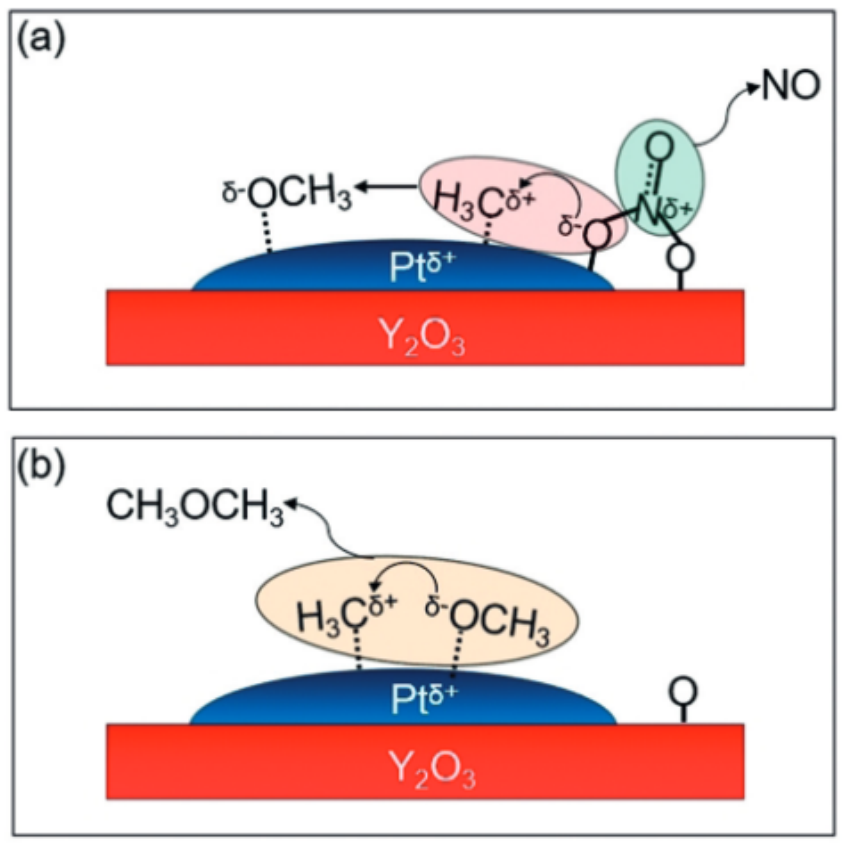
Figure 3. Probable steps in the oxidation of methane to DME on the catalyst’s surface. ( a ) Formation of OCH 3 − by the reaction of CH 3+ and NO 2 ; ( b ) Formation of DME from the reaction of OCH 3 − and CH 3+ . Reproduced with copyright permission from [27]